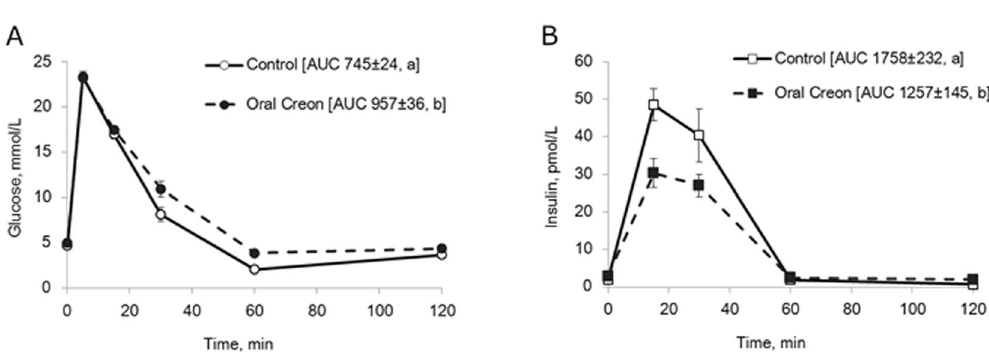
Figure 2. ( A , B ) Blood glucose ( A ) and plasma insulin concentrations ( B ) during an i.v. GTT without (control) and 1 h after oral enzyme (Creon ® ) treatment in healthy intact pigs. Data shown as mean ± SEM (n = 6) with area under the curve (AUC) values shown in brackets. Different letters indicate statistically significant differences (p < 0.05) between control and enzyme